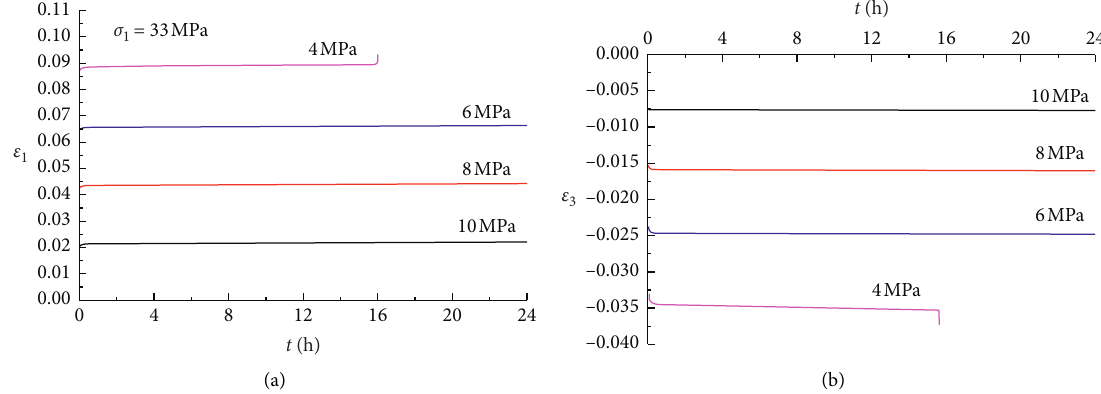
Figure 7: Unloading rheological curve cluster of coal samples with 60 ° fracture angle. (a) Cluster of axial creep curves. (b) Cluster of lateral creep